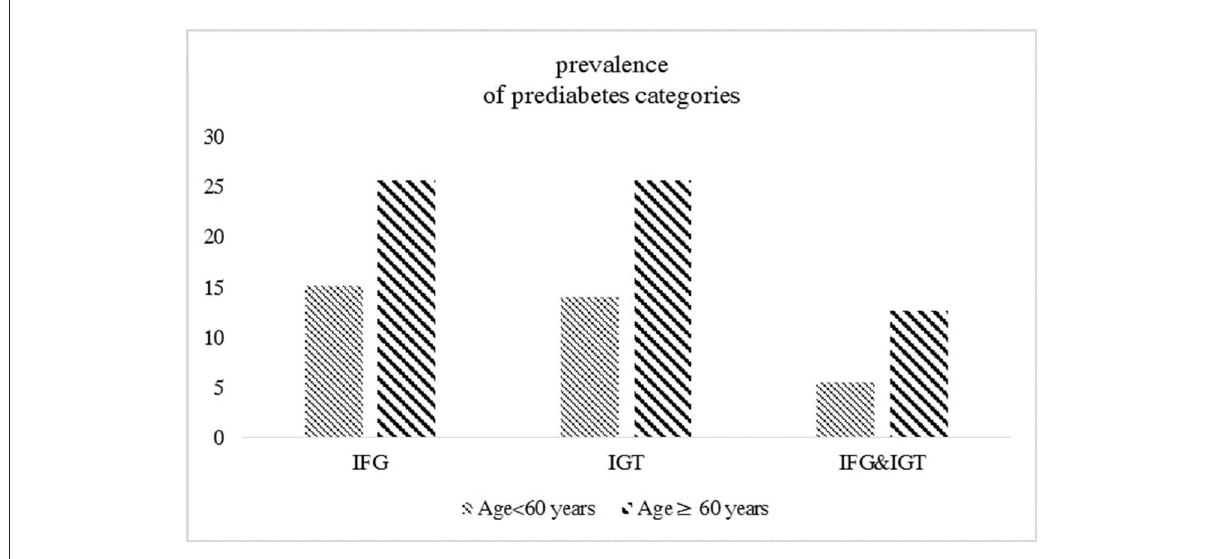
FIGURE2 The prevalence of prediabetes categories in the overall sample ( n = 5970) stratified by age